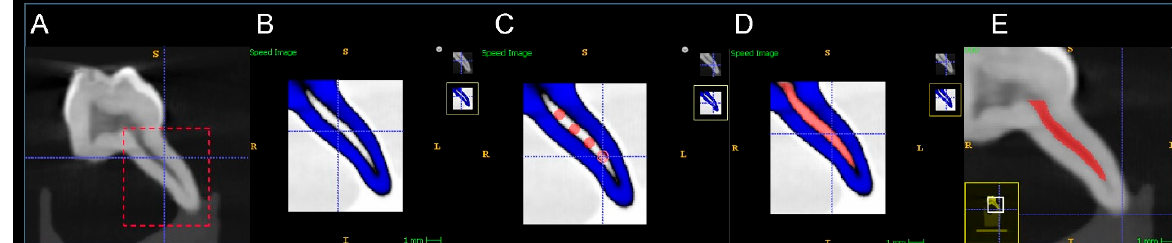
Figure 2. Thresholding for segmentation of the primary root canal. ( A ) Active contour “Snake” segmentation window; ( B ) Pre-segmentation speed image of a single primary root canal with threshold between − 1024 and 1200 GV; ( C ) Bubble placement to initialize the contour with 1.20 mm radius red bubbles; ( D ) Post-execution speed image of the root canal (red areas); ( E ) Final image of the primary root canal.